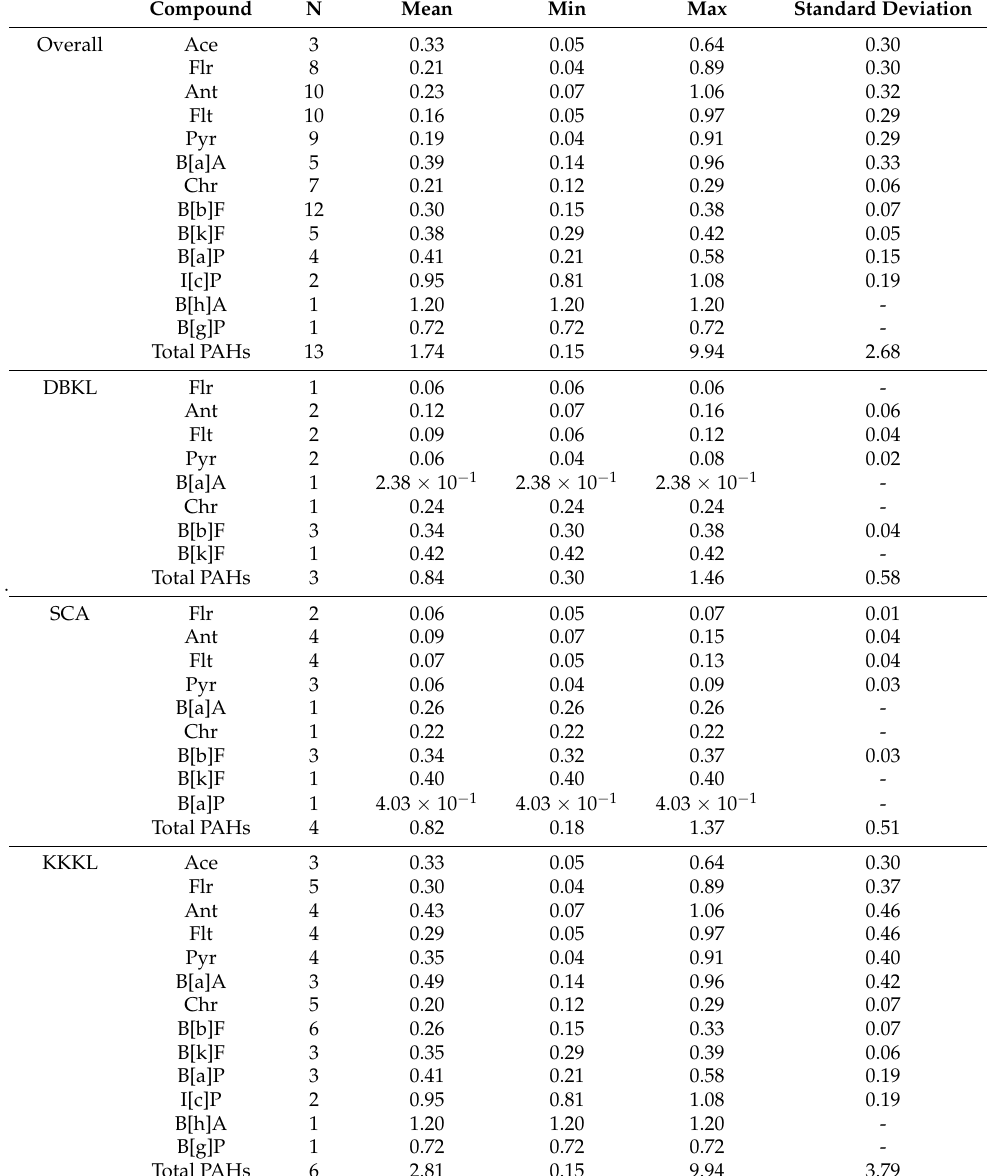
Table 2. Summary statistics for the PAHs concentrations (ng/m 3 ) in the PM 2.5